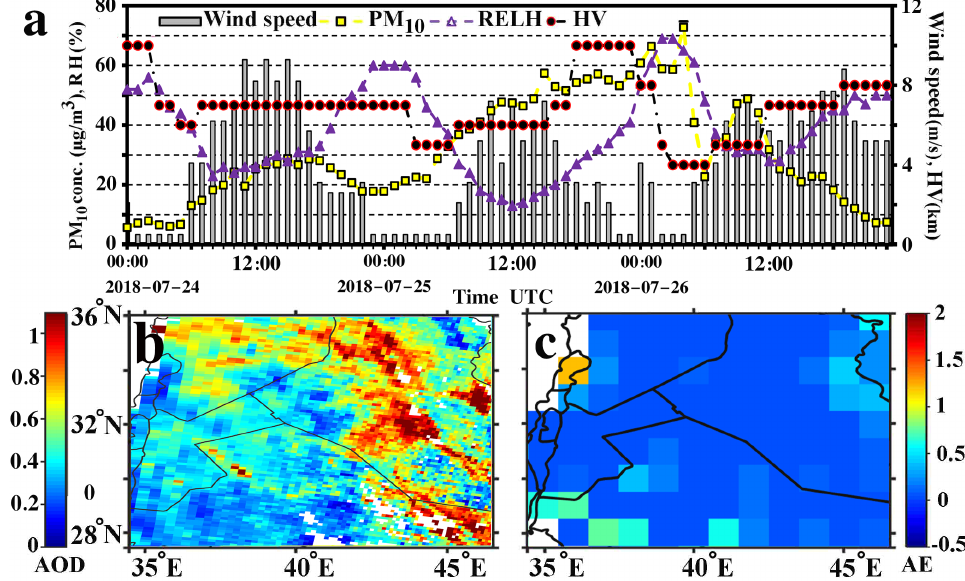
Figure 6. Sand and dust storm episode observed on 25 July 2018, which was an S-type SDS. ( a ) PM concentrations observed during the ground-based measurement, ( b ) MODIS 1 degree Deep Blue aerosol optical depth, and ( c ) MODIS 1 degree Deep Blue angström